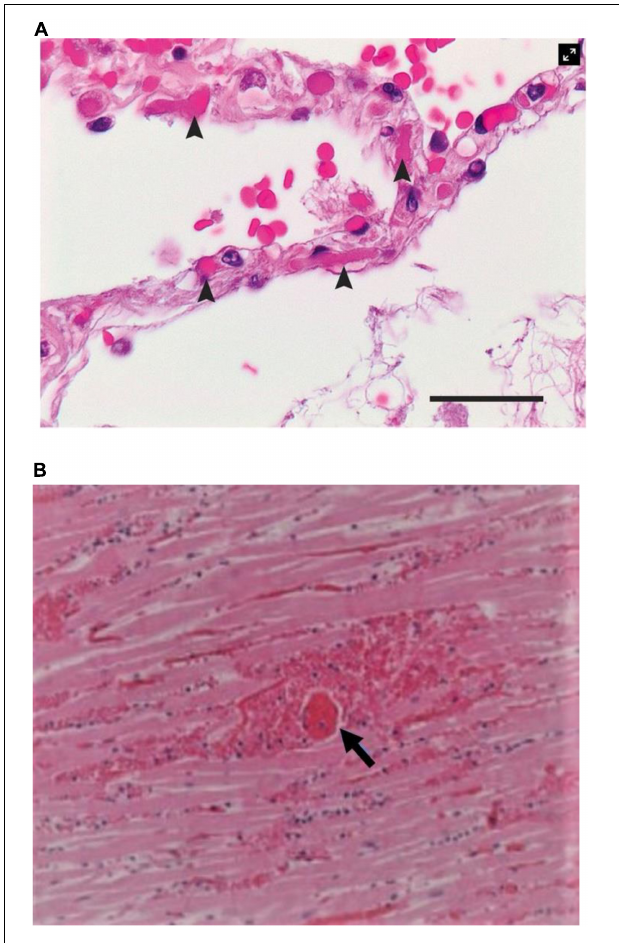
FIGURE 3 | Histological findings in patients with COVID-19. (A) Microthrombi (arrowheads) in the pulmonary perialveolar small vessels (12). Hematoxylin-eosin staining; the scale bar corresponds to 50 µ m. (B) Megakaryocyte-related (arrow) small vessels in the myocardium of a patient with a small myocardial necrotic injury. Fibrin thrombosis in a perforating vein associated with a myocardial infarction shows transmural myocardial necrosis and neutrophilic infiltrates (15). Source: (A) Ackermann et al. (12). Used with permission. (B) Rapkiewicz et al. (15). Reproduced